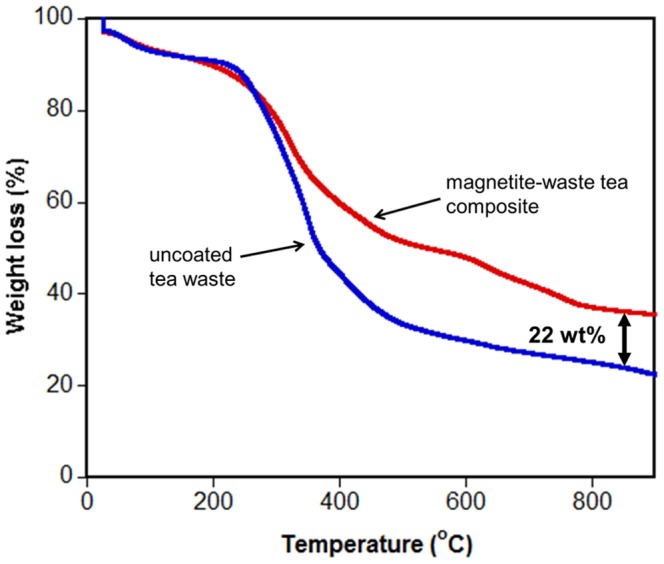
TGA analyses of the uncoated and magnetite-waste tea composite showing that the magnetite coating accounts for about 22% of the total mass of the composite.